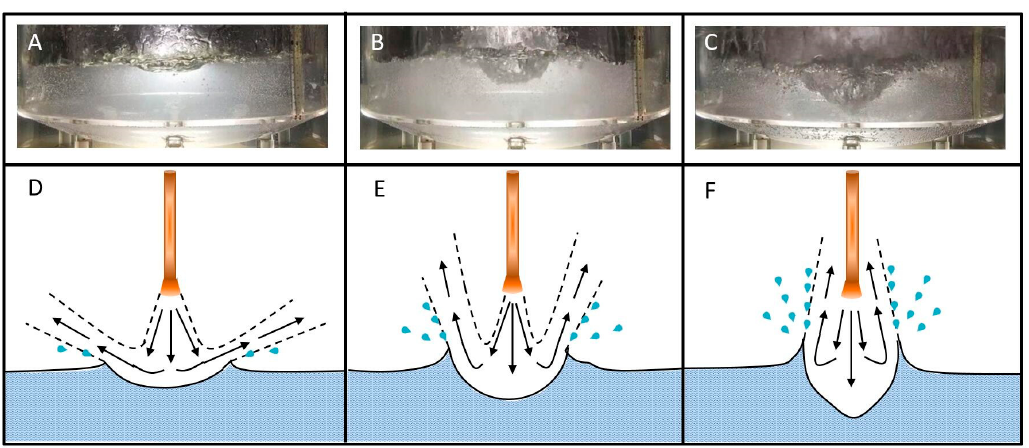
Figure 4. Impact cavity morphology and splashing mode. ( A ). disc shape cavity; ( B ). bowl shape cavity; ( C ). cone shape cavity; ( D ). “dimpling” mode; ( E ). “splashing” mode; ( F ). “penetrating” mode. Table 3. Impact cavity shapes under the di ff erent top-blown gas jet